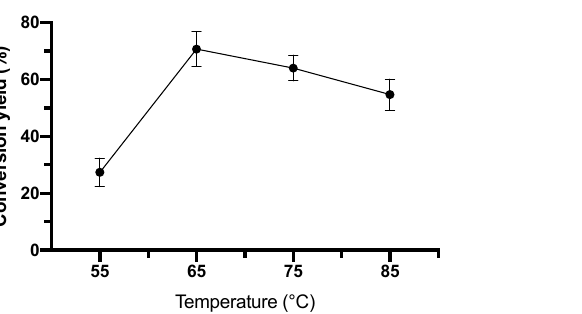
Figure 4 . Effect of temperature (°C) on the esterification yield of UDCA-monoglyceride. All quantifications were performed in triplicate.